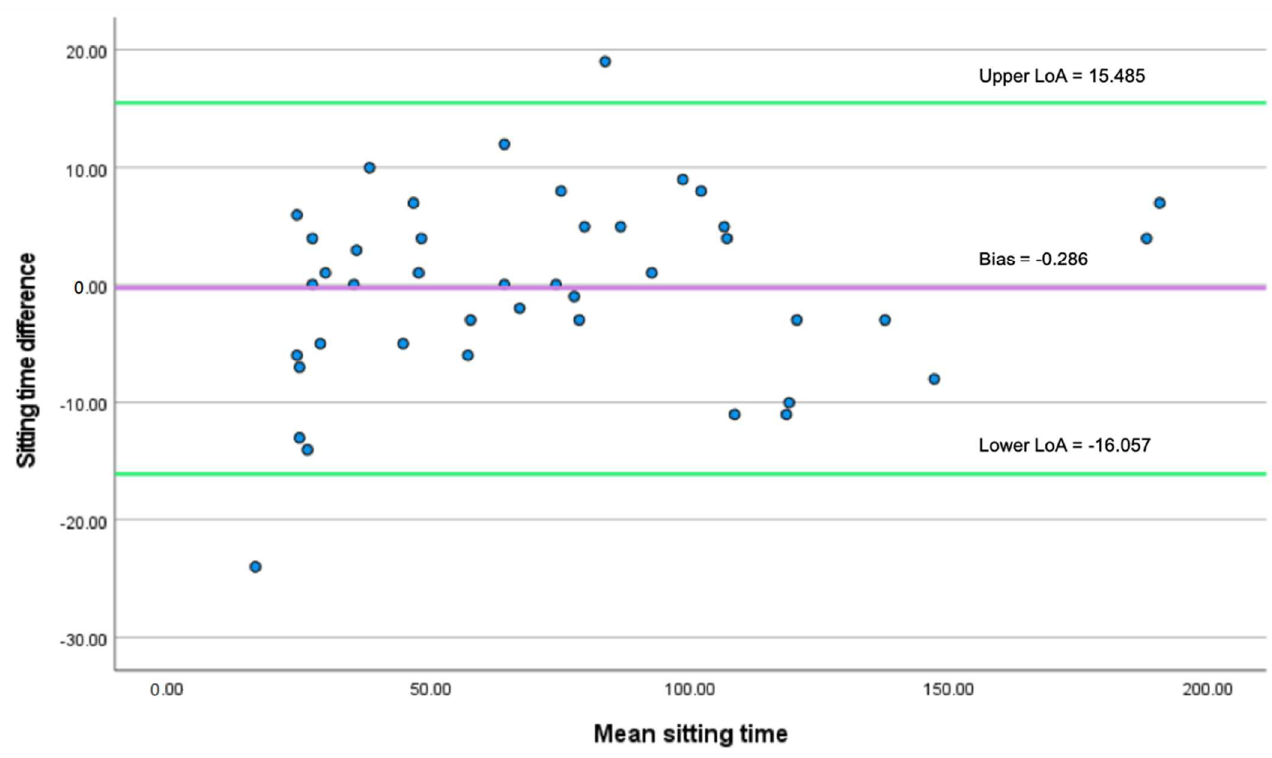
Figure 5. The Bland–Altman plot of agreement between mat sensor and video